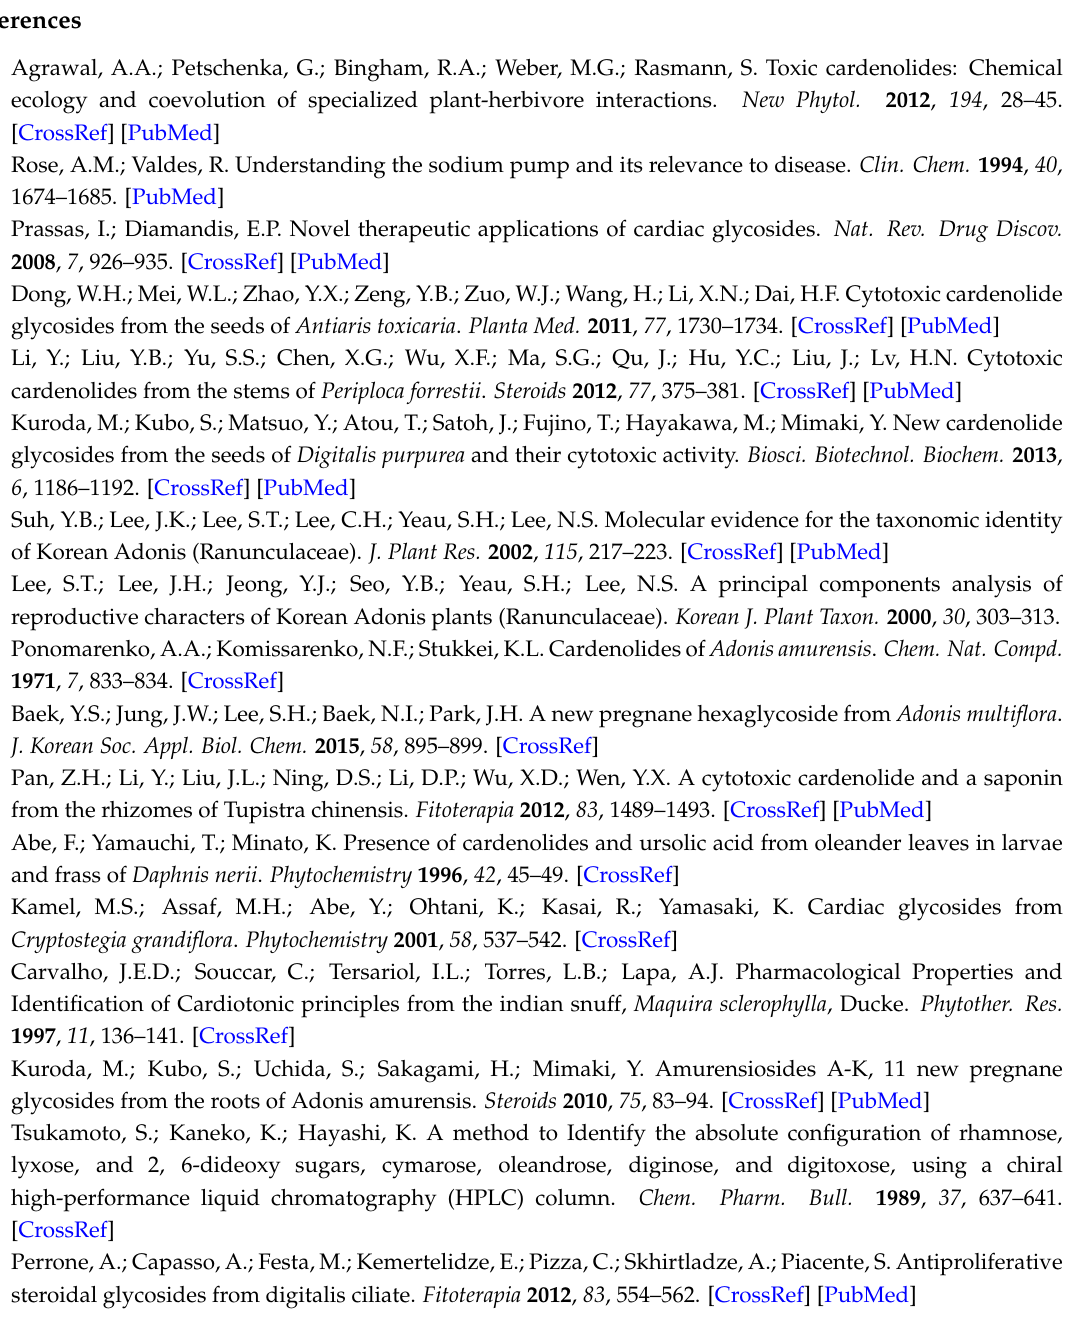
Supplementary Materials: 1 H-NMR and 13 C-NMR spectra of 1 and 6 and HMBC spectrum of 6 are available as supporting data. Supplementary materials can be accessed at: http://www.mdpi.com/1420-3049/20/